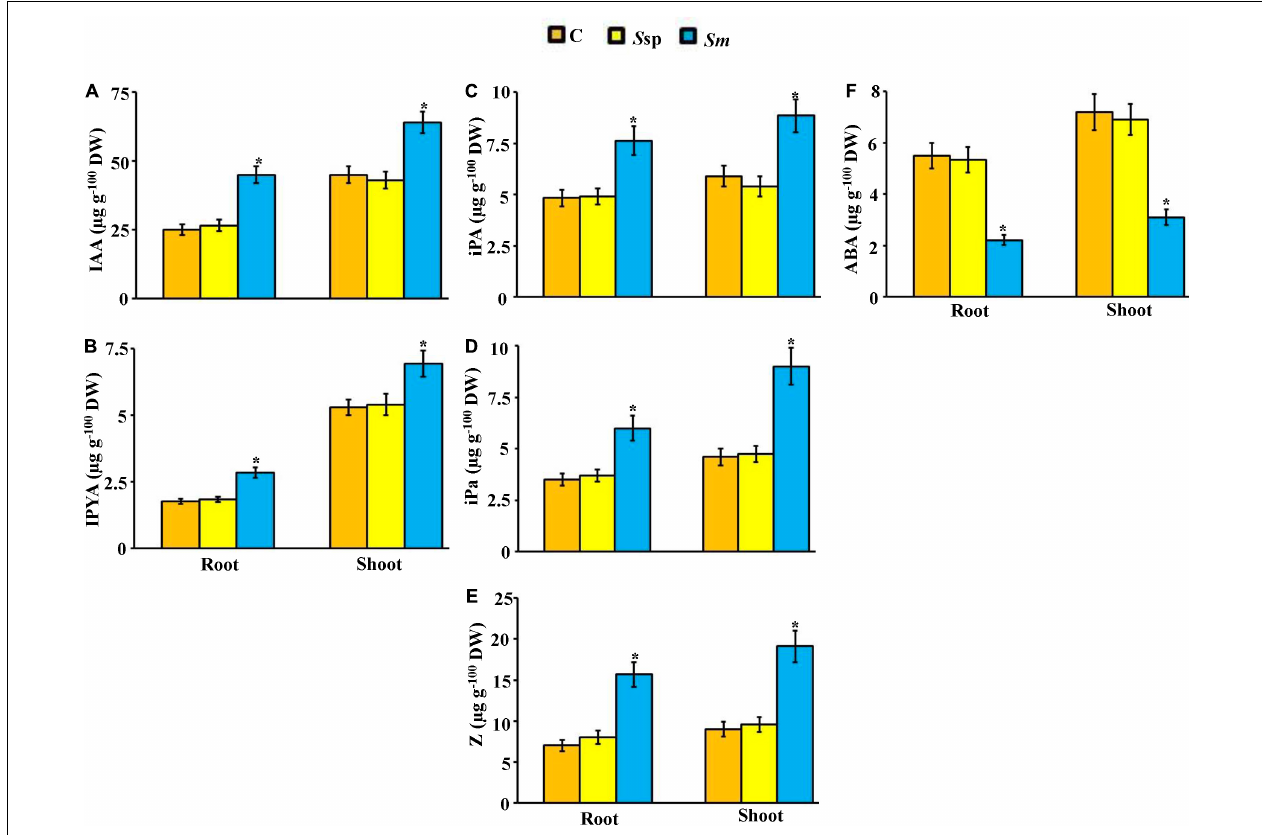
FIGURE 8 | Effect of the endophytic Streptomyces mutabilis UAE1 on endogenous PGR contents of mangrove. Endogenous contents of auxins (A) IAA and (B) IPYA; cytokinins (C) iPA, (D) iPa, and (E) Z; and (F) ABA in mangrove root and shoot tissues after treatment with C, S sp, and Sm . Mangrove seedlings were grown in an evaporative-cooled greenhouse and maintained at 30 ± 2 ◦ C. Values are means ± SE of 16 replicates for each treatment from two different independent experiments. Mean values followed by an asterisk are significantly ( P < 0.05) different from each other according to Fisher’s protected LSD test. Bars represent SE. Endogenous contents of auxins, cytokinins, and ABA were measured at 9 months post planting the inoculated mangrove propagules. DW, dry weight; C, control (non-inoculated inorganic salt starch broth); S sp, PA-non-producing isolate #5 ( Streptomyces sp. 19-388); Sm , PA-producing isolate #24 ( S. mutabilis UAE1); PA, polyamine; IAA, indole-3-acetic acid; IPYA, indole-3-pyruvic acid; iPA, isopentenyl adenine; iPa, isopentenyl adenoside; Z, zeatin; ABA, abscisic